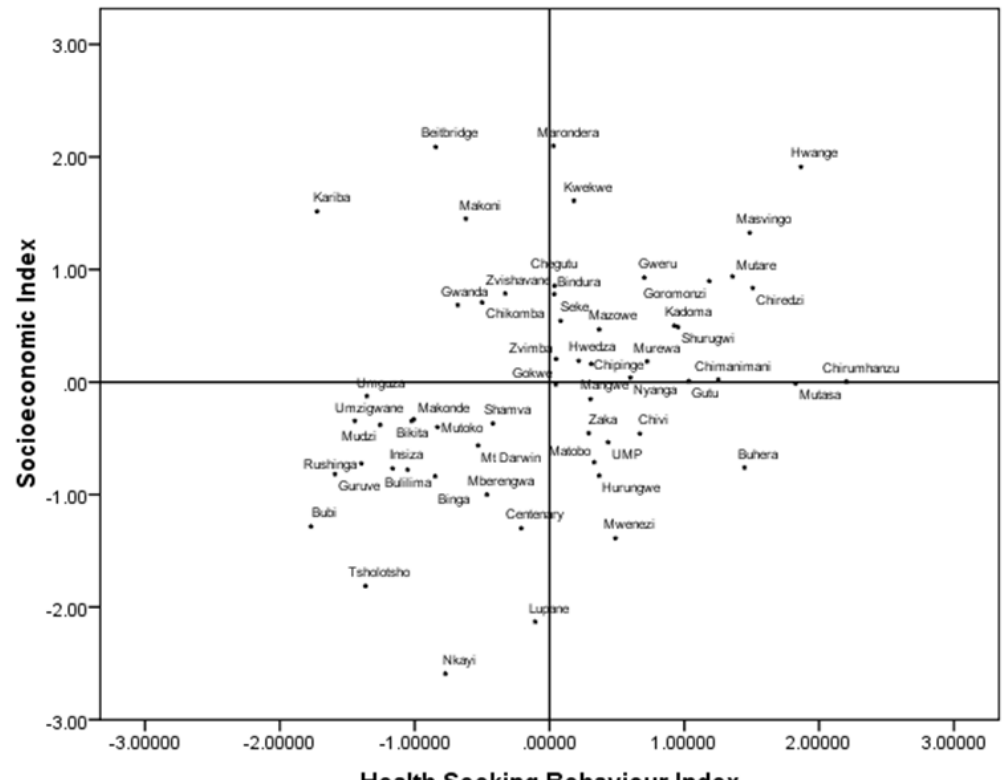
Figure 3. Scatterplot of Socioeconomic Index and Health Seeking Behaviour